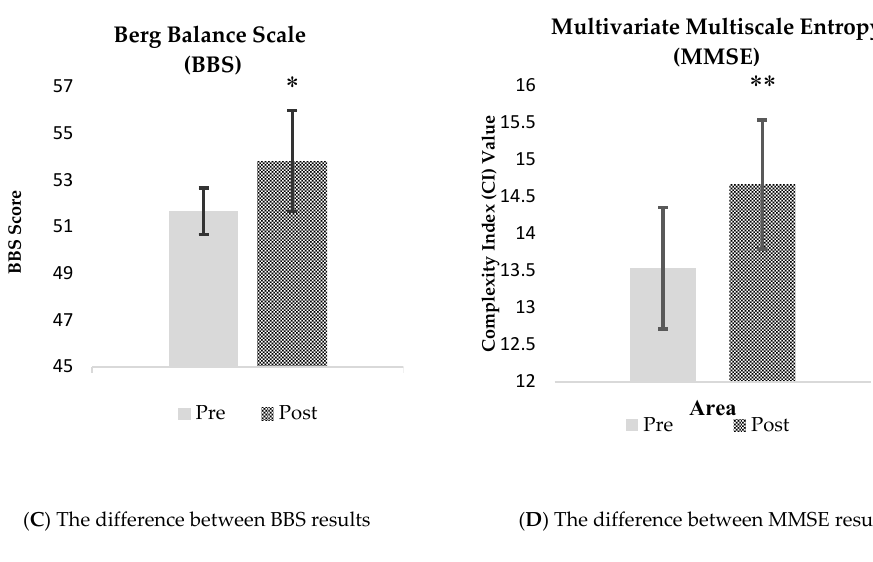
Figure 1. The di ff erence results between pre-test and post-test values with MIT training. Figure 1. The difference results between pre ‐ test and post ‐ test values with MIT training.